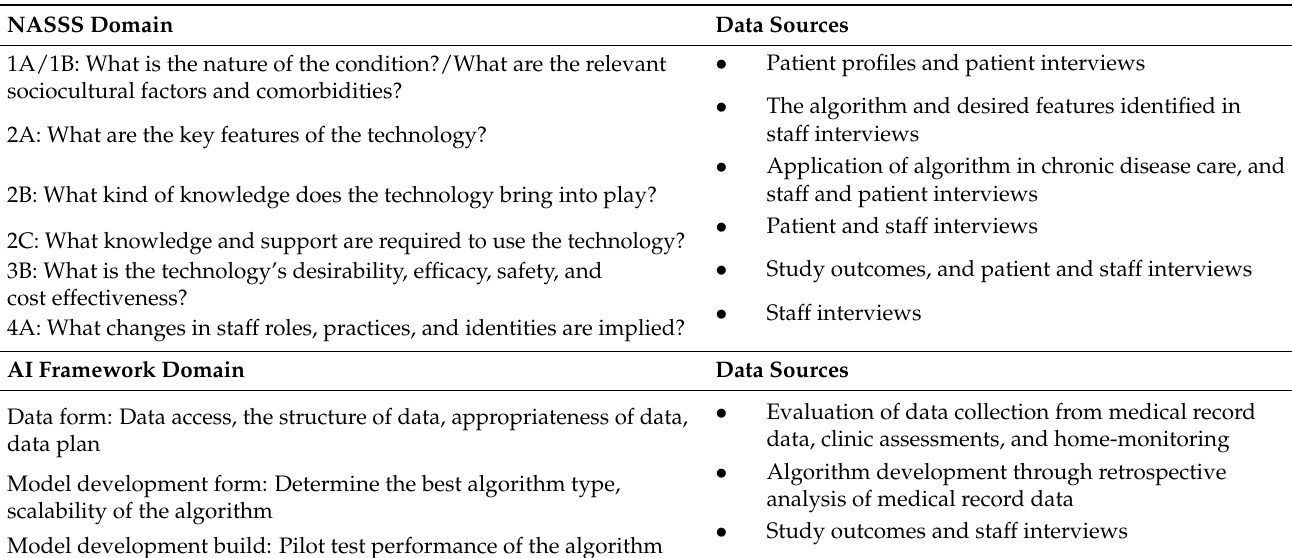
Table 2. Modified NASSS and AI framework domains and associated data sources